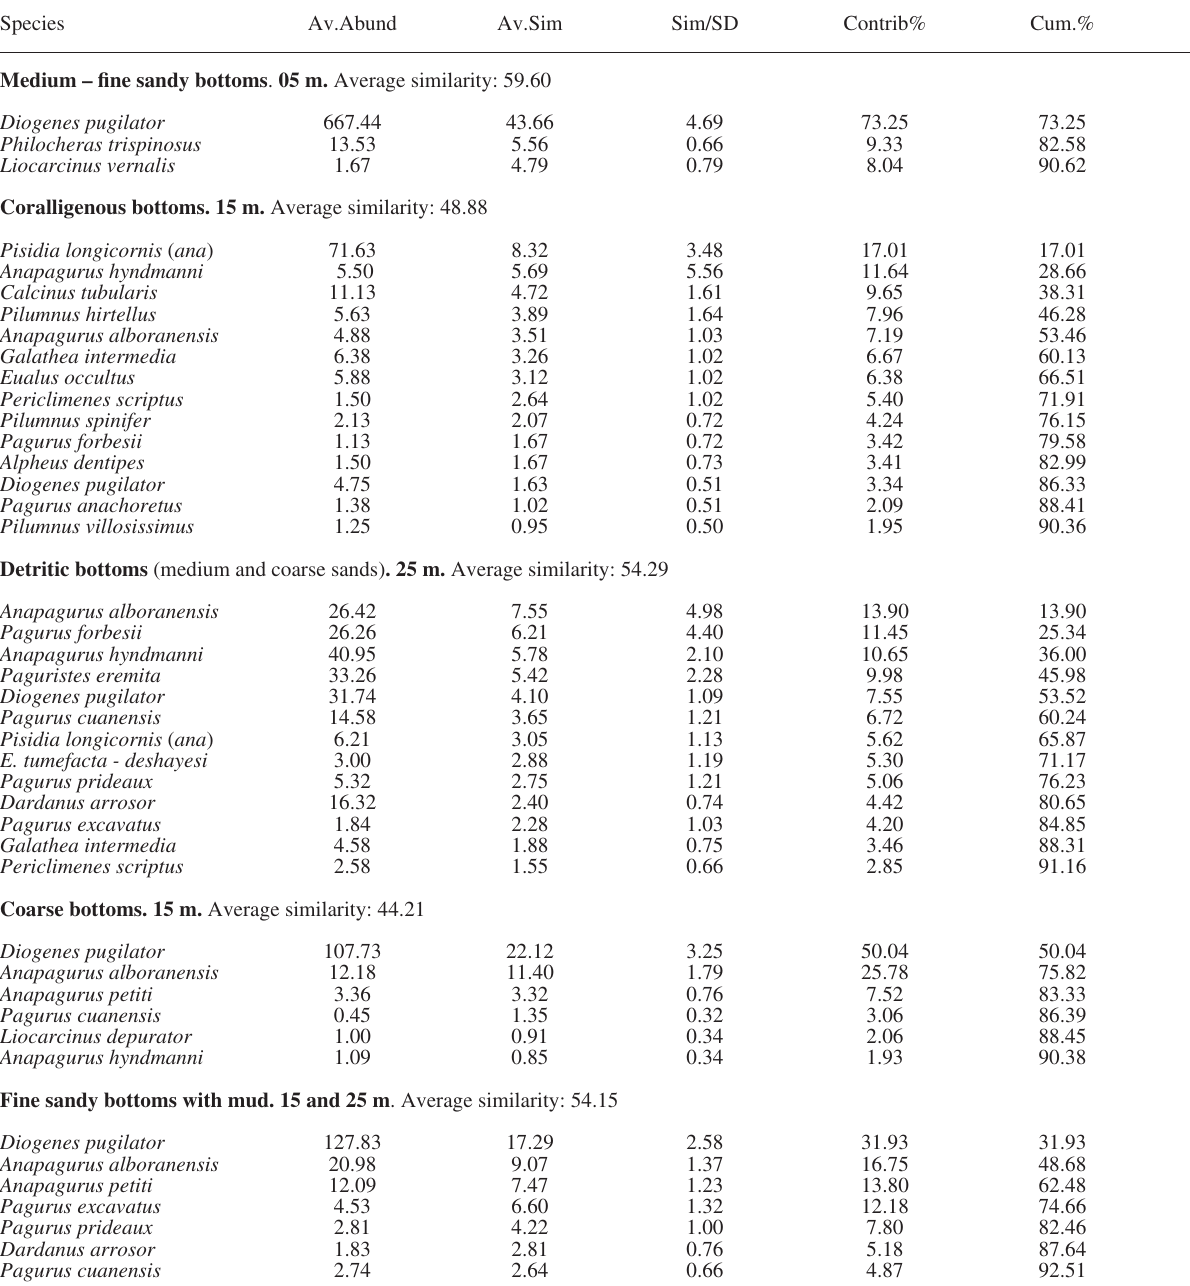
Table 7. – Results of the Similarity Percentages - species contributions (SIMPER) of the different assemblages by substrates. Species Av.Abund Av.Sim Sim/SD Contrib%